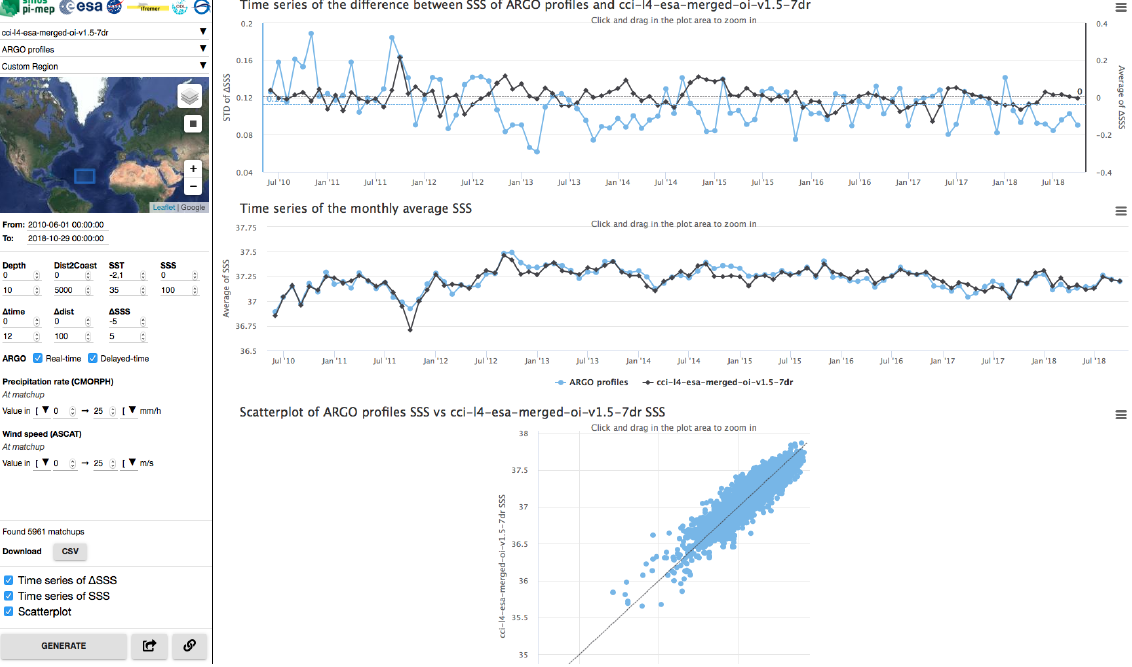
Figure 16. Illustration of the MDB